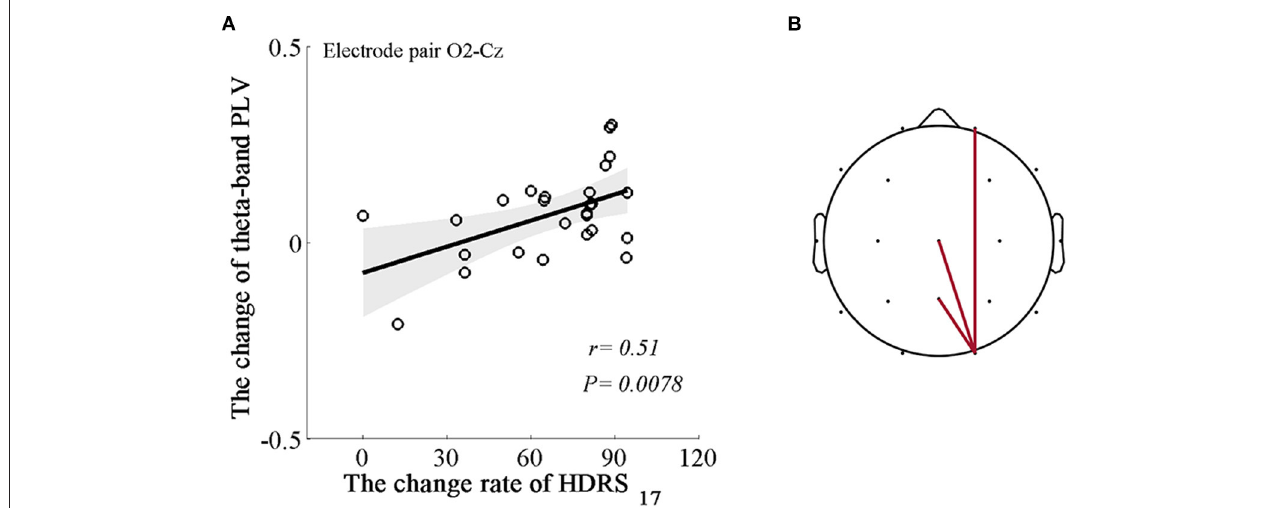
FIGURE 3 | Associations between the changes in the dynamics of the EEG theta rhythm and the change rate of HDRS scores. (A) An example of the positive correlation between 1 theta PLV at the right occipital-central areas (electrode pair O2-Cz) and the change rate of HDRS scores ( r = 0.51, P = 0.0078). Shaded areas delineate the confidence interval of 95%. (B) Topological correlations between 1 theta PLV and the change rate of HDRS scores. Each edge represents significantly positive correlations based on a P -value of 0.05.